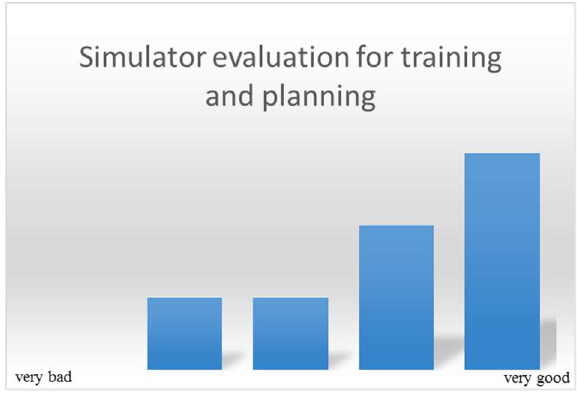
Figure 9 . Simulator applicability for training and